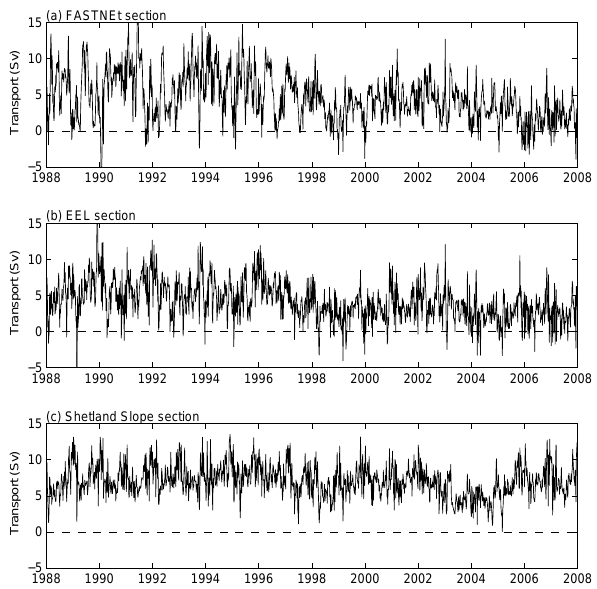
Figure 4. Slope Current transport at FASTNEt, EEL and Shetland Slope sections, 5-day averages over 1988–2007 in